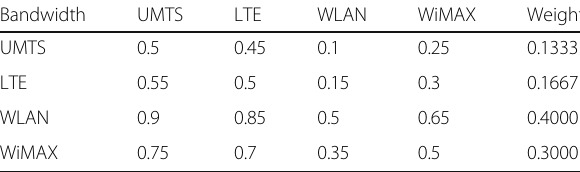
Table 11 Fuzzy consistent matrix and weights for